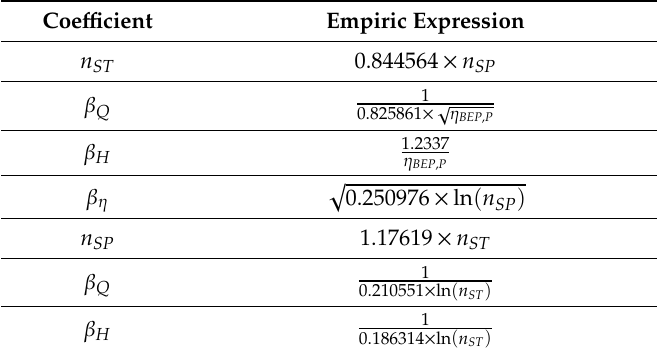
Table 4. Empirical relationship to define the best e ffi ciency point of a machine as a function of the specific speed proposed by [20]. In Table 4, the variable η BEP , P is the best e ffi ciency obtained from the machine working as a pump.